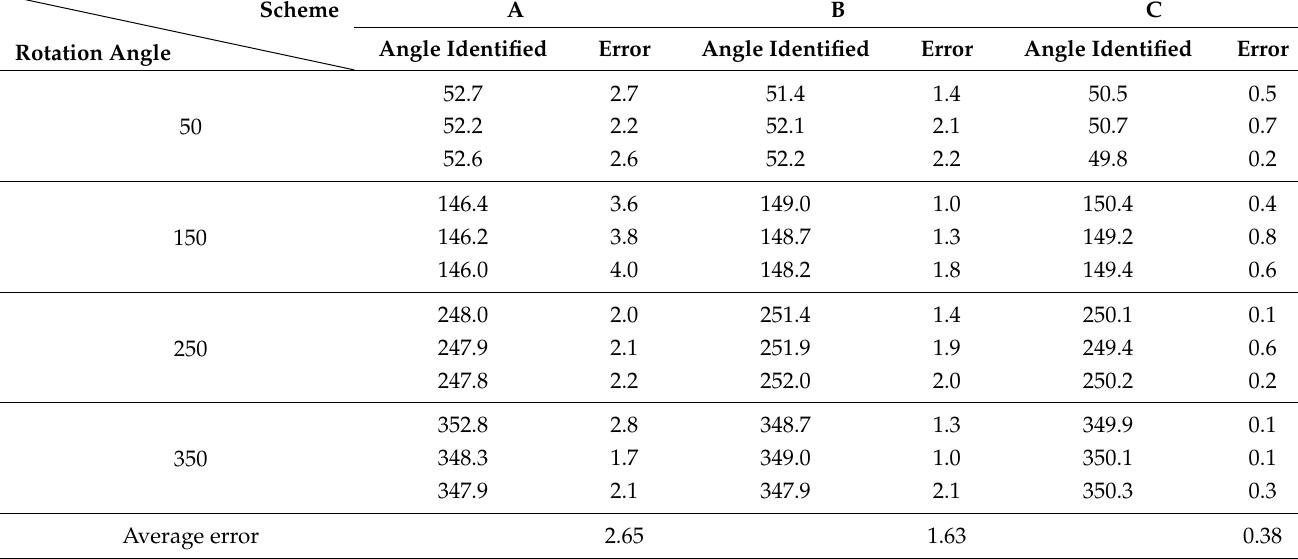
Table 1. Results of rotation angle (degree)